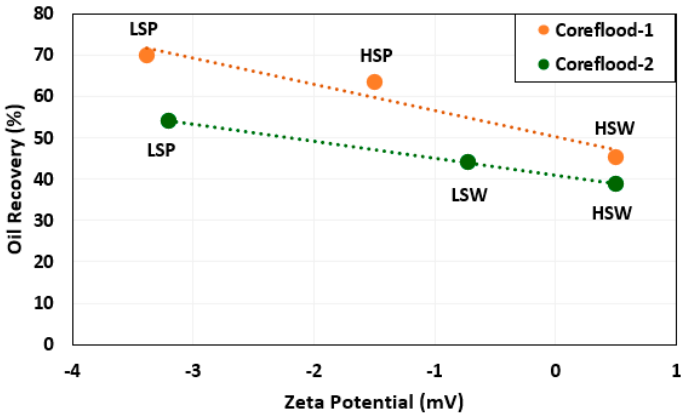
Figure 17. Oil recovery as a function of the zeta potential, showing higher recovery using the hybrid method compared to standalone processes. Coreflood-1 shows a comparison between PF and LSPF, while coreflood-2 displays a comparison between LSW and LSPF [139].